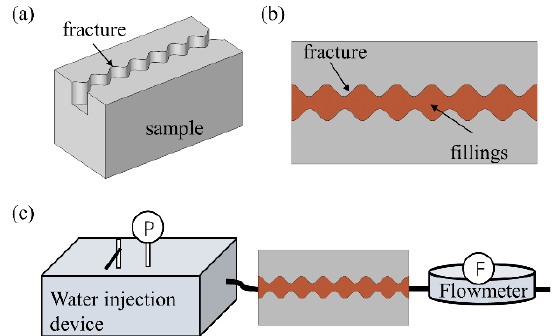
Figure 12. Experiment of the model: ( a ) a rock-like sample with the fracture; ( b ) the filled fracture; ( c ) water injection process.